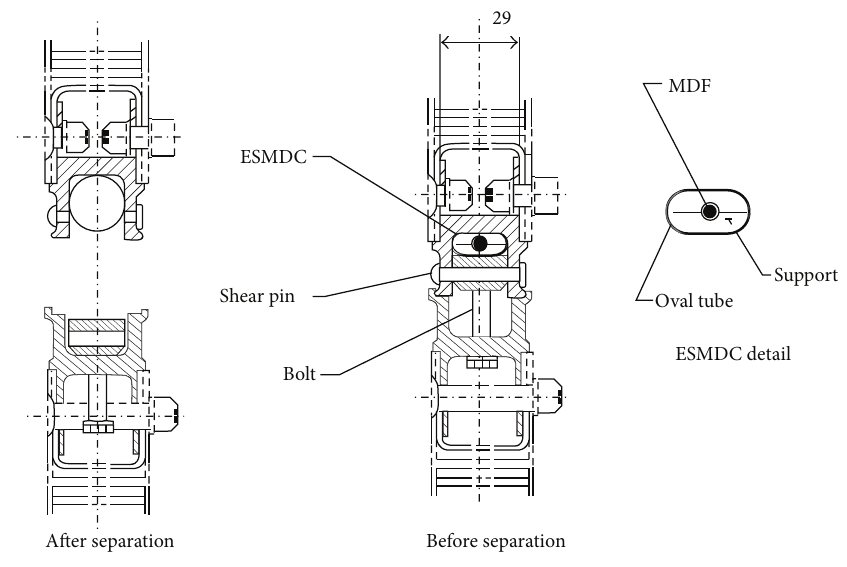
Figure 1: A pyro-separation system [9].